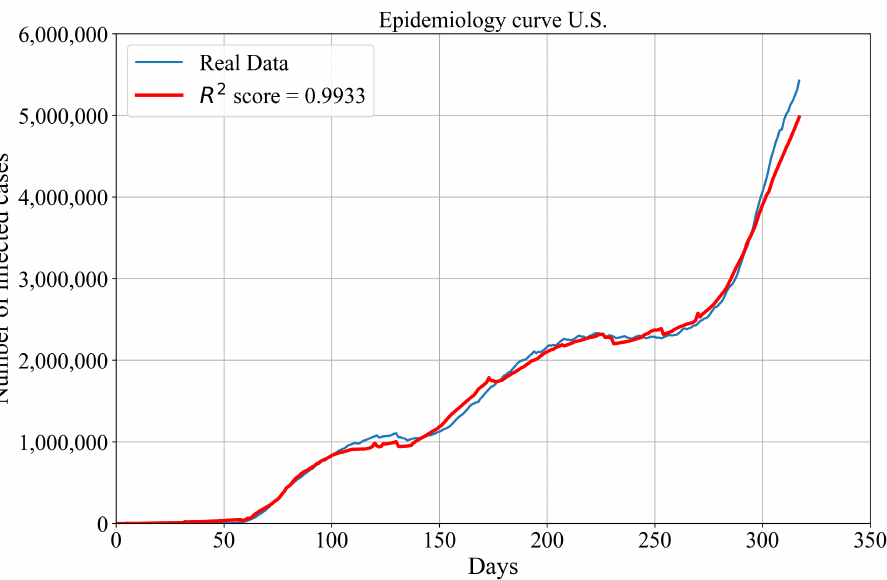
Figure 5. The comparison of estimated actual patients in the U.S. with the real data from the